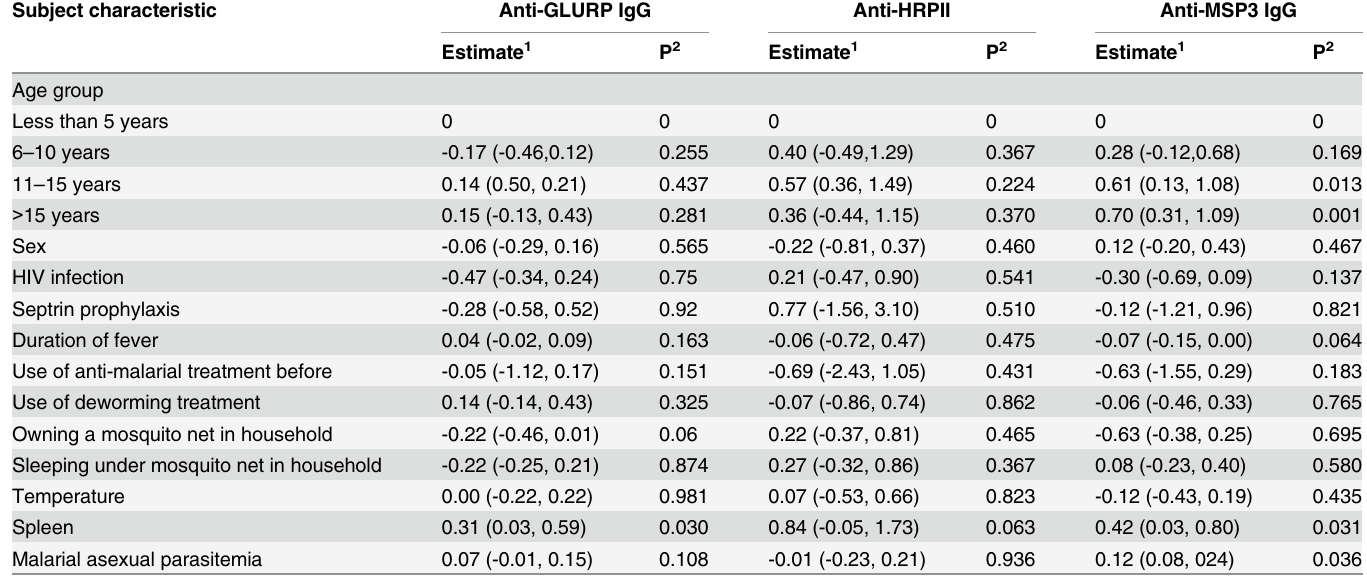
Table 2. Multivariate analysis of subject characteristics and antibody